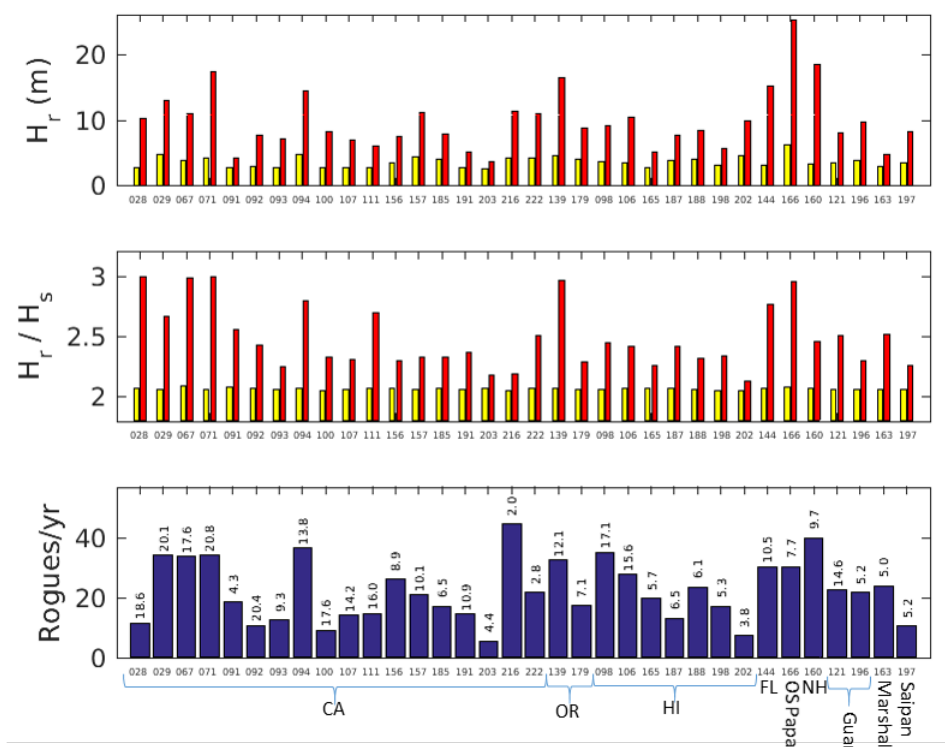
Figure 3. Rogue wave statistics at the 34 analyzed buoy locations. Top panel : Max (red bars) and Mean (yellow bars) rogue wave height. Middle panel : Max (red) and Mean (yellow) ratio of rogue height to significant wave height, as computed for each event at each buoy site. Bottom panel : Average number of rogues recorded per year at each site (values at top of each bar give total length of dataset at the site, in years). Buoy numbers are provided on the x -axis, with geographical buoy locations specified at bottom.